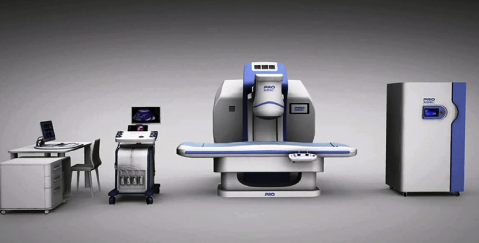
Figure 2. PRO2008 system developed by Shenzhen PRO HITU Medical Co., Ltd. The C-arm ( center ) positions the transducers for overhead HIFU treatment with a multi-element array [42]. Treatment is monitored by the control system ( left ), and the HIFU delivery is maintained with the water cooling system ( right